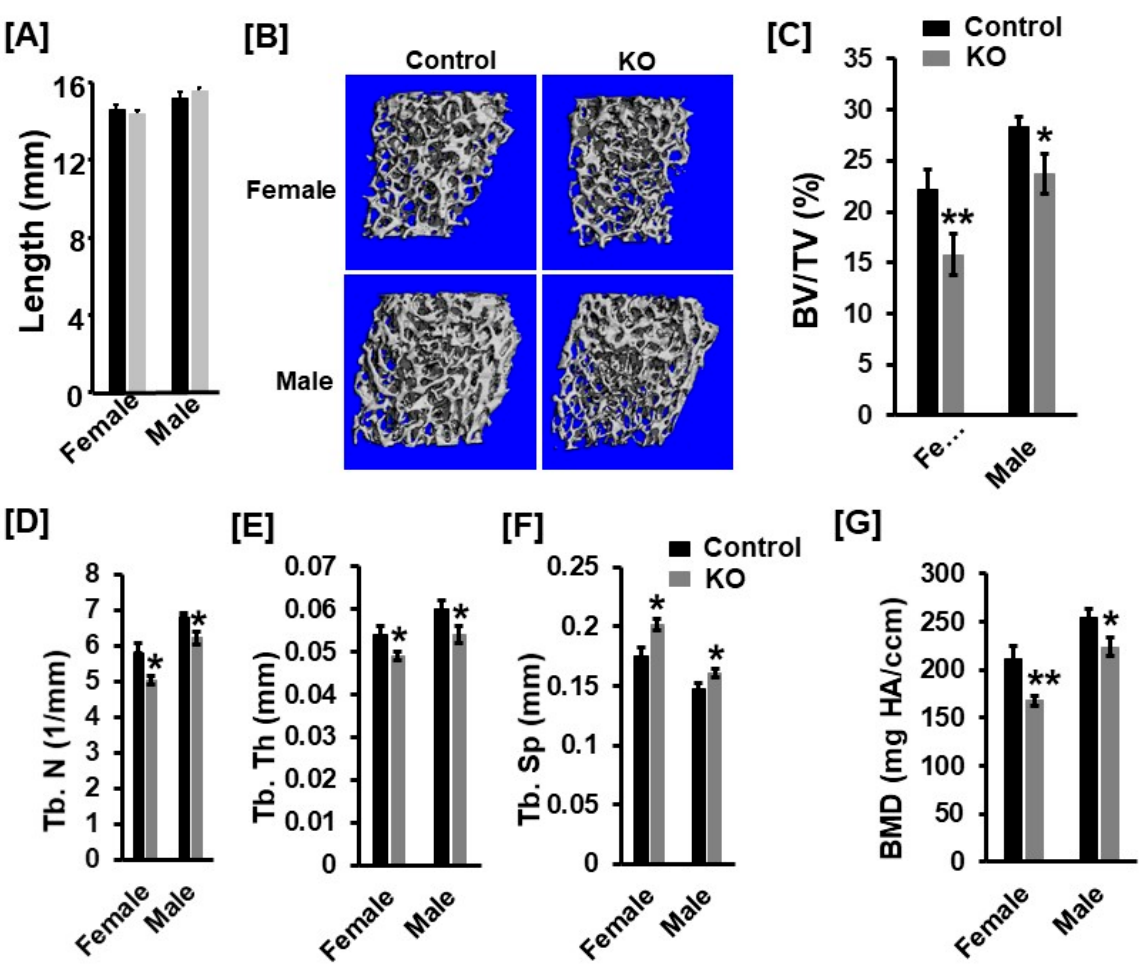
Figure 1. Mice with disruption of Tspan3 exhibit low bone mineral density in the distal femurs. ( A ) Femur length of the Tspan3 knockout (KO) and the control littermates at 13 weeks of age. ( B ) Micro-CT images of the trabecular bone of the distal femurs of 13-week-old Tspan3 KO and control littermates ( C – G ) Quantitative micro-CT data of the trabecular bone of the distal femur. TV, tissue volume; BV, bone volume; Tb. N, trabecular number; Tb. Th, trabecular thickness; Tb. Sp, trabecular spacing; vBMD, volumetric bone mineral density. Values are mean ± SEM ( n = 7–9). *: p < 0.05; **: p < 0.01 as compared to the control littermates.